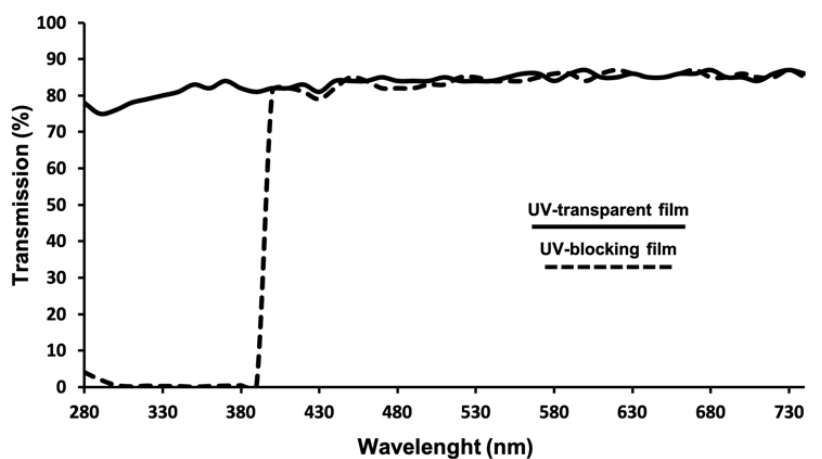
Figure 1. Spectral transmission of the UV-transparent and UV-blocking polyethylene films used in this study.